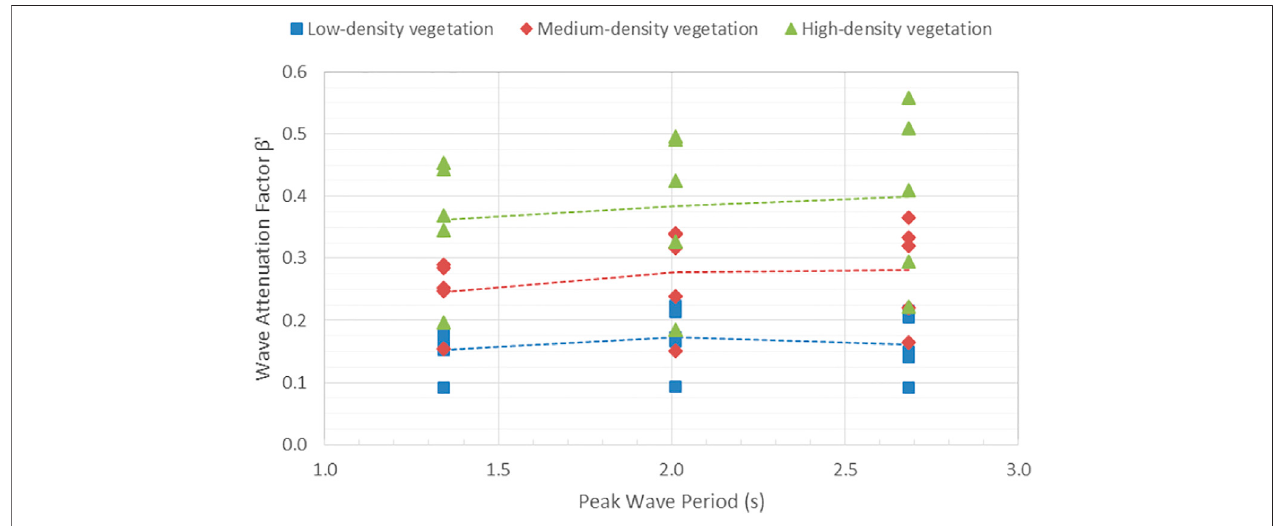
FIGURE 8 | Variation in wave attenuation factor β ′ with wave peak period for arti fi cial marshes with different vegetation densities. Symbols denote results from individual tests spanning a range of wave heights and water depths. Dashed lines connect average β ’ values at each wave period.